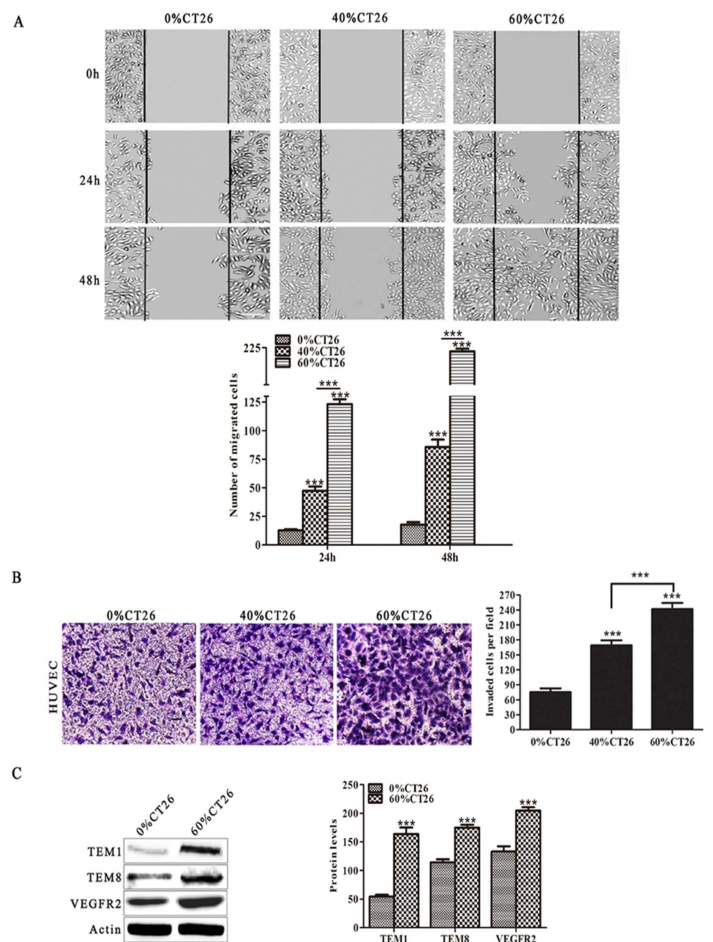
Figure 1. HUVECs induced by 60% CT26 cell supernatant enhanced the capacity of migration and invasion and highly expressed tumor vascular endothelial cell markers. ( A ) The wound-healing test was performed after HUVECs were induced for 48h (scale bar 50 µ m); ( B ) the transwell assay was done to examine the invasion ability of HUVECs induced by 0, 40, and 60% CT26 cell supernatant. The number of invaded cells was counted in three random fields. Representative images of invaded cells are shown (scale bar 50 µ m); ( C ) Western blot was used to show the expression of the tumor endothelial cell markers TEM1, TEM8 and VEGFR2. Data from three independent experiments were expressed as the mean ± SD, (* p < 0.05; ** p < 0.01; *** p <